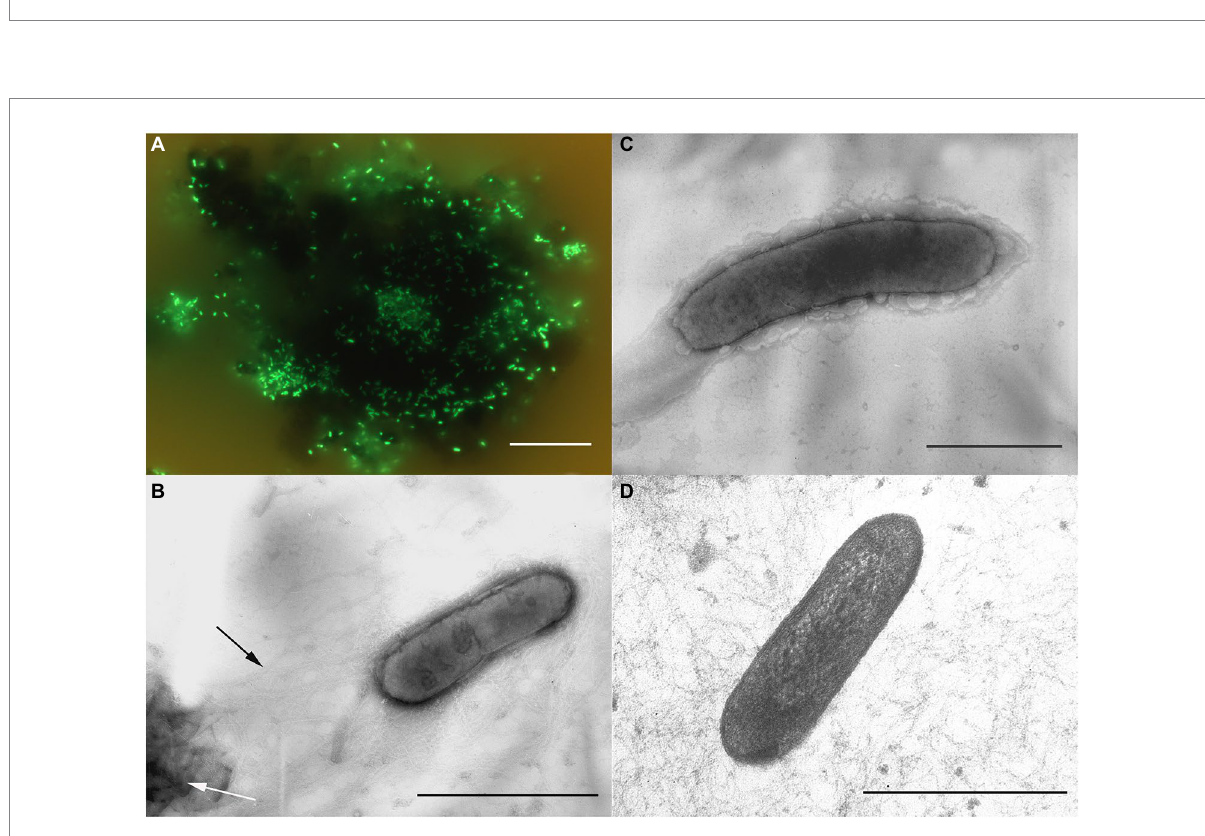
FIGURE 3 Cellular morphology of strain Es71-Z0120 T . (A) Acridine orange-stained cells colonizing an SF particle. (B) Electron micrograph of a negatively stained cell grown with SF. Black arrow indicates a network of pili-like appendages, white arrow points at a mineral particle of SF. (C) Electron micrograph of a negatively stained cell grown with soluble Fe(III)-citrate. (D) Ultrathin section of a cell. Bars: a = 10 μ m, b–d = 0.3 μ